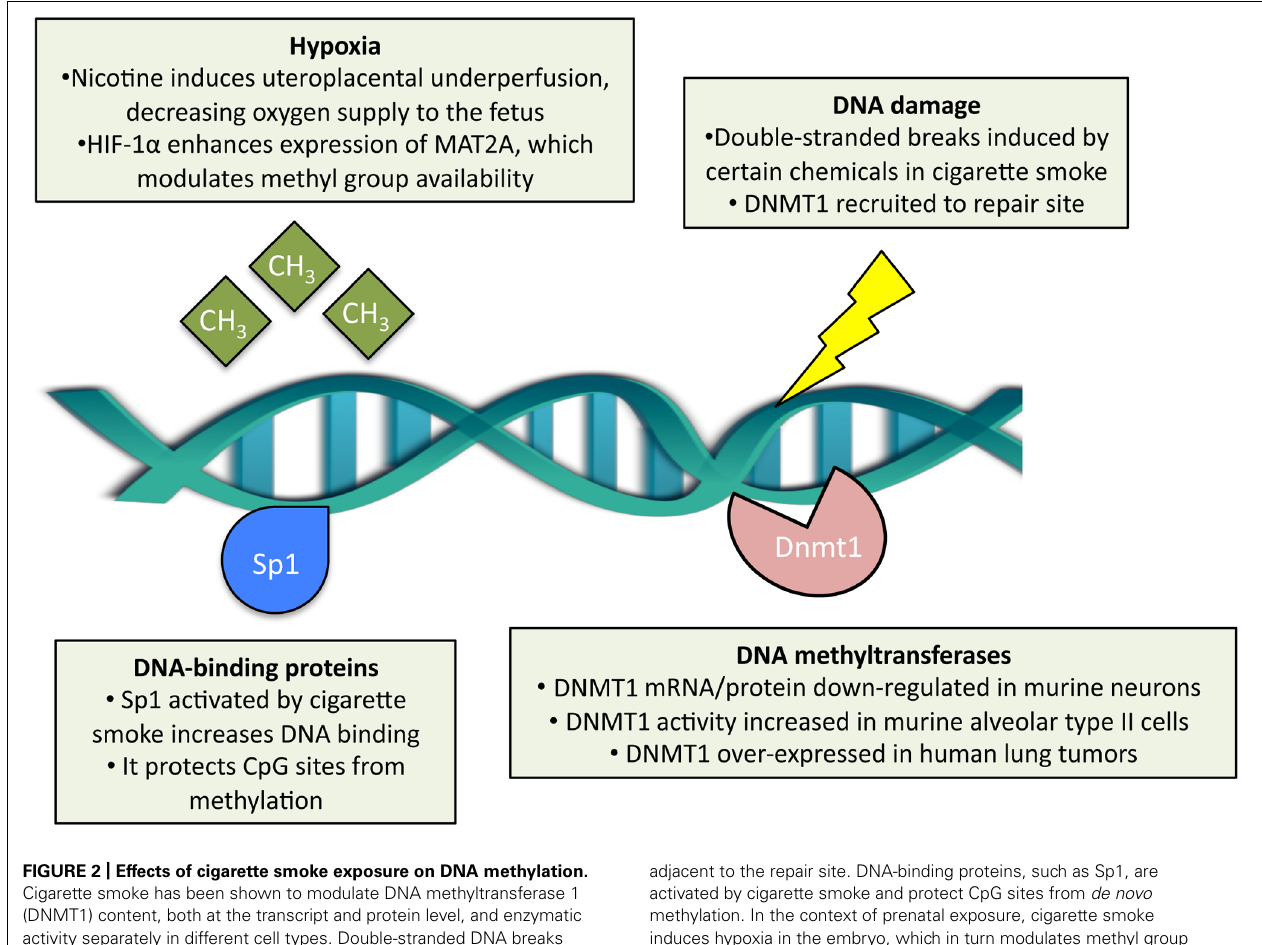
FIGURE 2 | Effects of cigarette smoke exposure on DNA methylation. Cigarette smoke has been shown to modulate DNA methyltransferase 1 (DNMT1) content, both at the transcript and protein level, and enzymatic activity separately in different cell types. Double-stranded DNA breaks may be induced by cigarette smoke, which subsequently recruits DNMT1